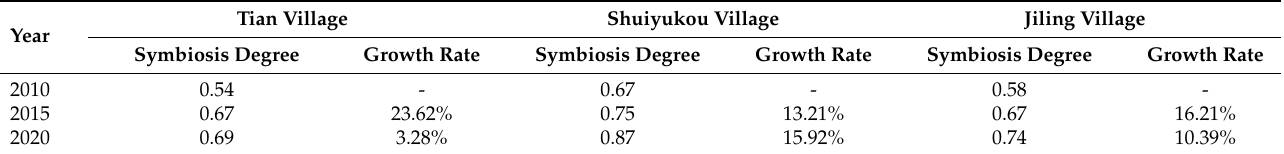
Table 9. Symbiosis degree between production land and living land in rural